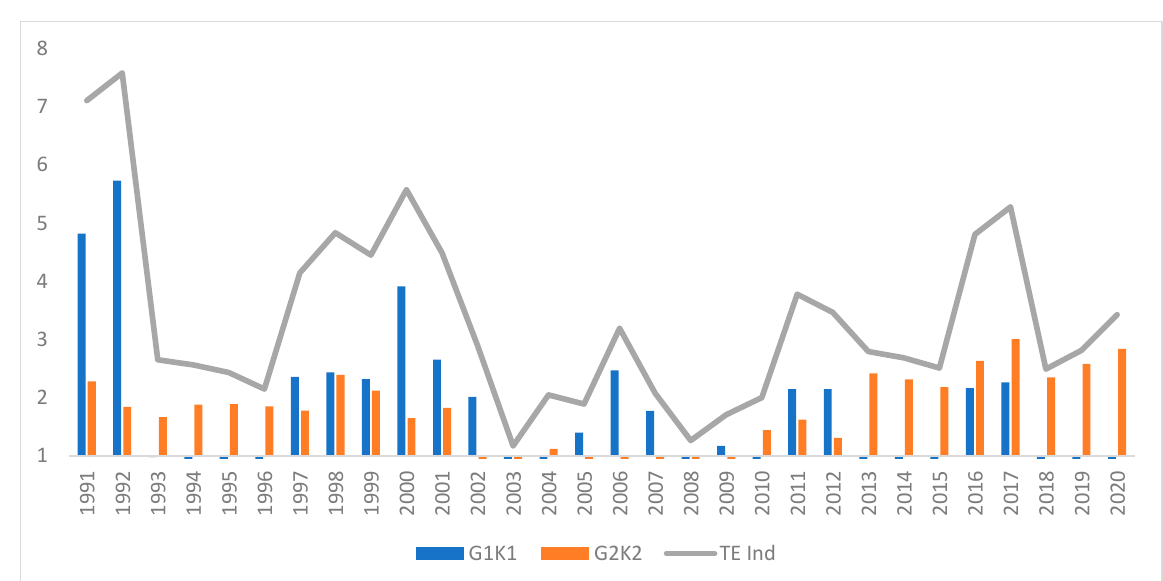
Figure 6. Technology and efficiency index and sub-indices.